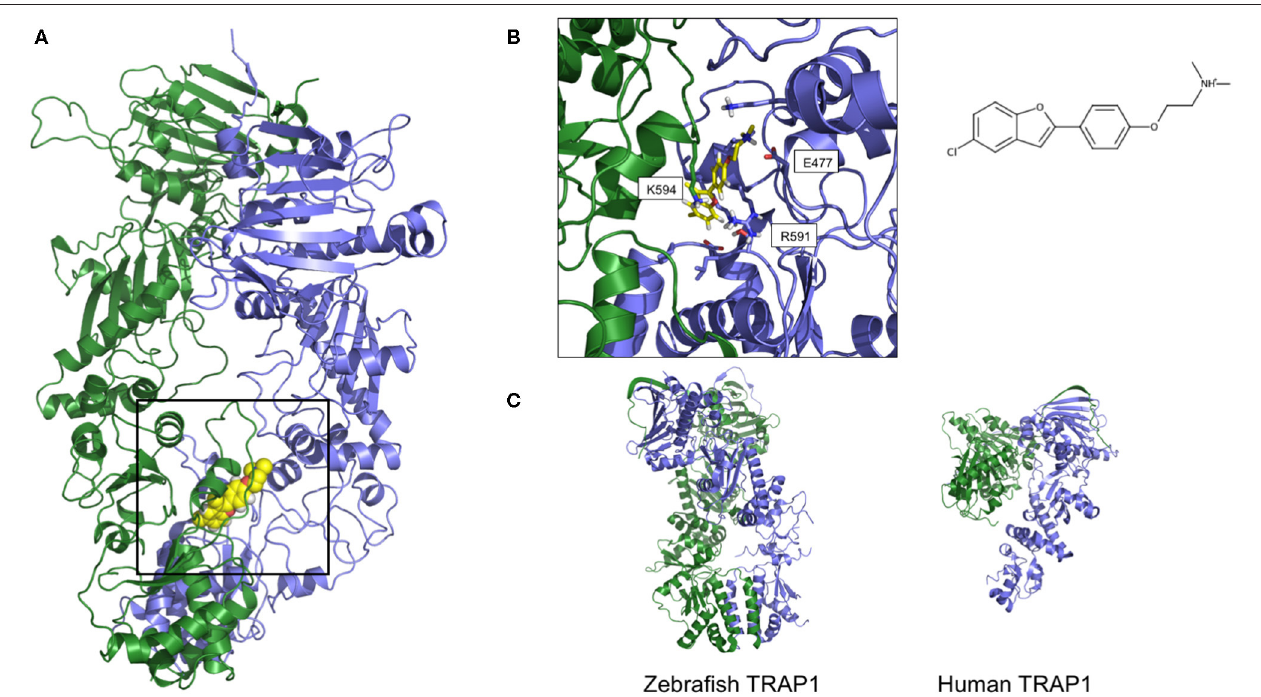
FIGURE 4 | Two orientations of the predicted 3D structure of HSP90 with one allosteric activator bound. (A) The full-length structure of the complex, with the allosteric activator displayed as yellow van der Waals spheres. (B) Zoom on the structure of the activator and the contacting Hsp90 residues, together with its structure formula. The compound and the structure derive from simulations described in Sattin et al. ( 149), run starting from structure 2cg9.pdb (C) The 3D structures of Zebrafish and Human TRAP1, respectively from 6d14.pdb and